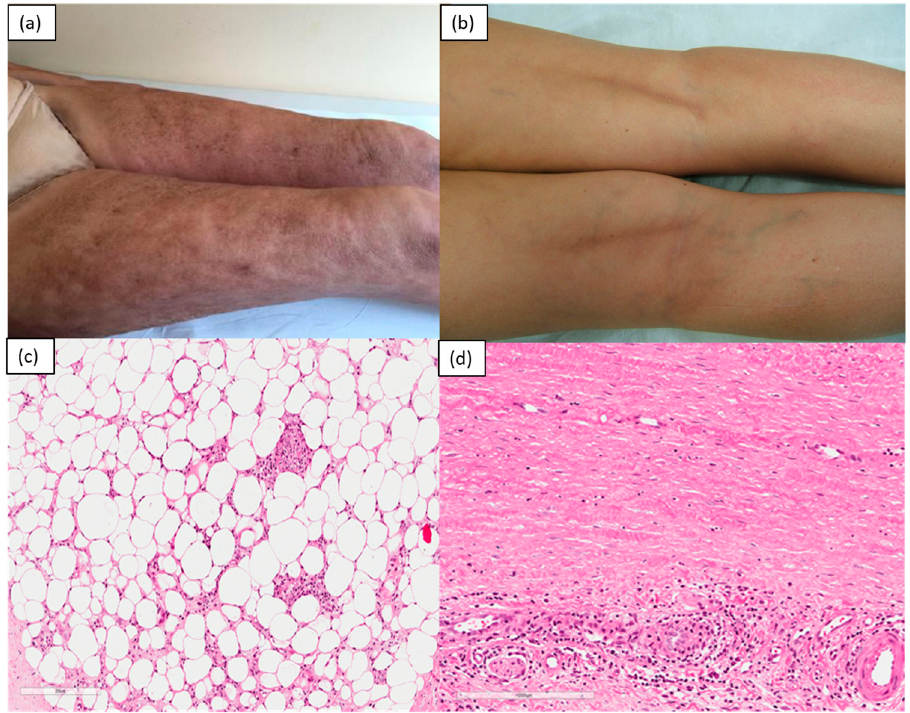
Figure 3. A 58-year-old female patient. Irregular “peau d’orange” appearance of the skin of both lower limbs, due to the sclerotic process occurring predominantly at a deep level ( a ); linear depres- sions following the course of the blood vessels between muscle groups (“groove sign”) to the popliteal cavities bilaterally ( b ). H&E specimen (original magnification: 100 × ) showing inflammatory infiltrate extended to subcutaneous adipose tissue and fascia ( c ), and detail of the fascia, which is thickened and fibrotic, with central fibrinoid degeneration and a marked inflammatory infiltrate that is rich in eosinophilic granulocytes ( d ).